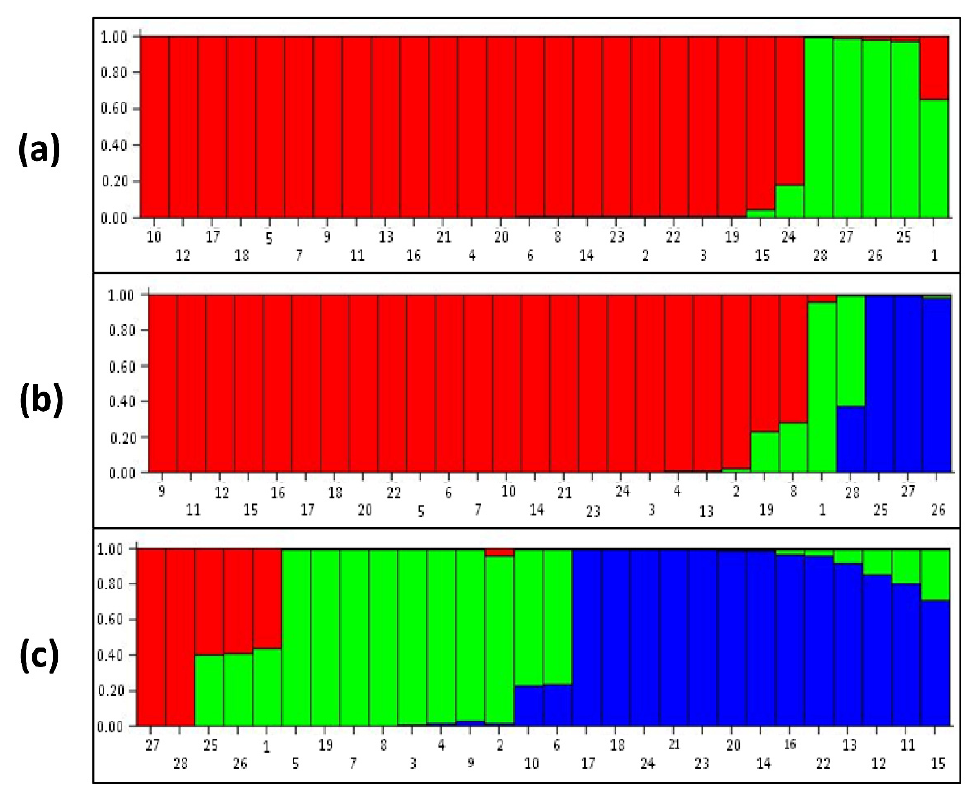
Figure 2. STRUCTURE bar plots of ( a ) g SSR (K = 2), ( b ) EST-SSR (K = 3), and ( c ) SCoT (K = 3) of 28 accessions of Tinospora .